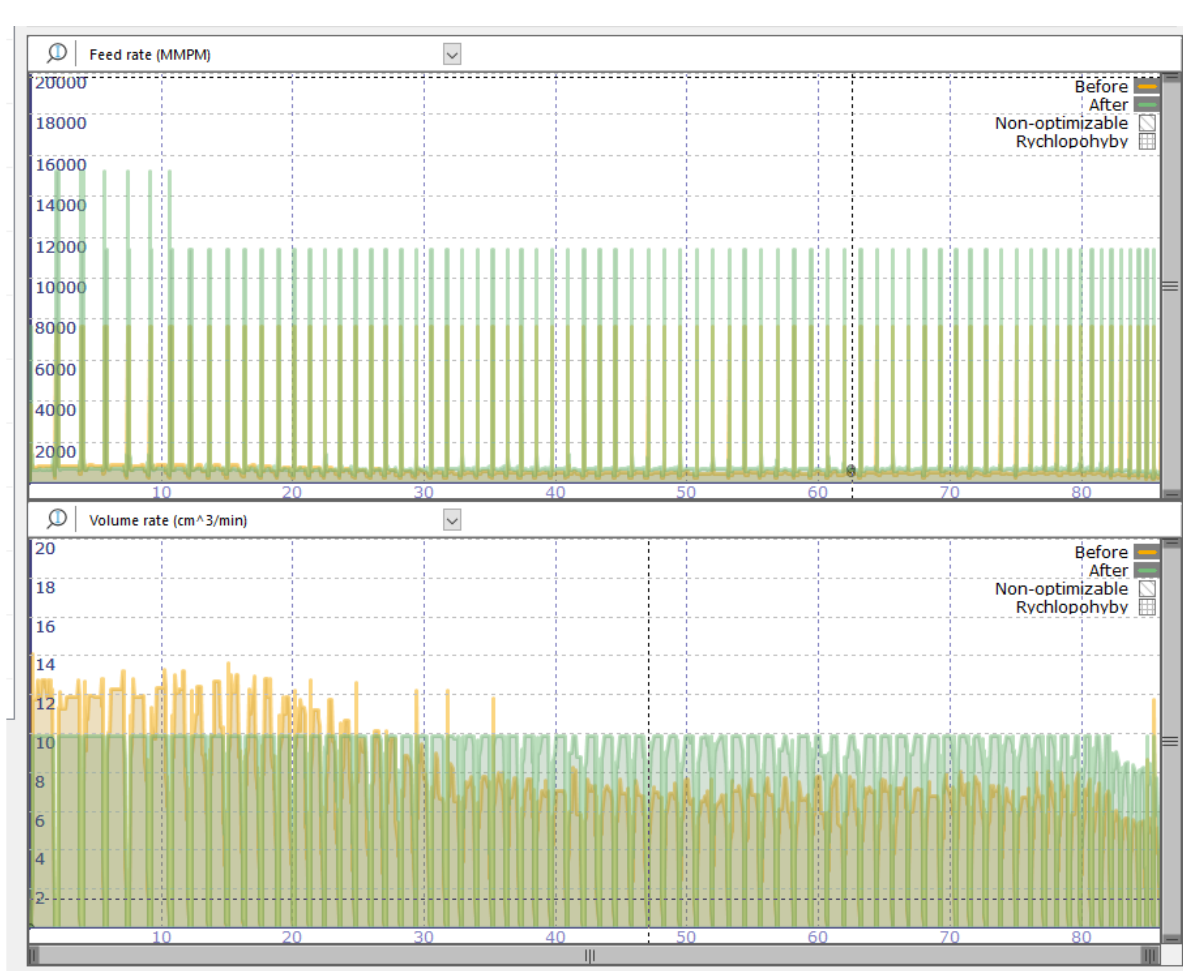
Figure 11. Comparison of real machining times.